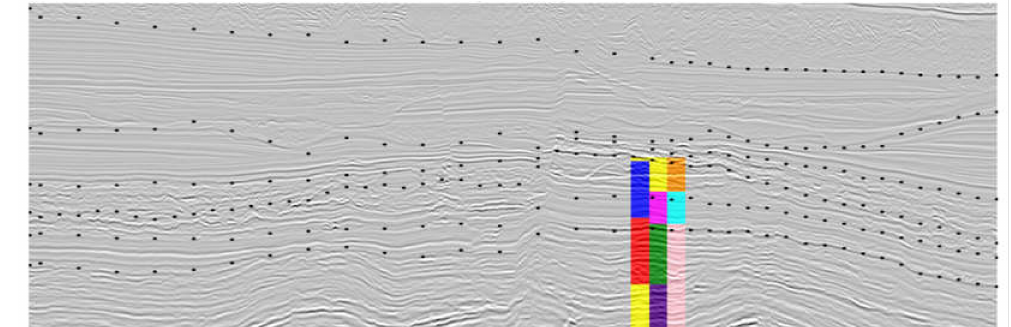
Figure 23. Example of association result, shown in color columns over seismic vertical slice. Black dots indicate main geological boundaries according to geophysicist interpretation on seismic data. Left column: clean well groups; Center column: association results; Right column: seismic groups. A very good fit is present for association results (central column) and seismic group (right column). Unfortunately, no well log information is available on the upper section of the seismic data, so only three seismic facies could be associated with the well